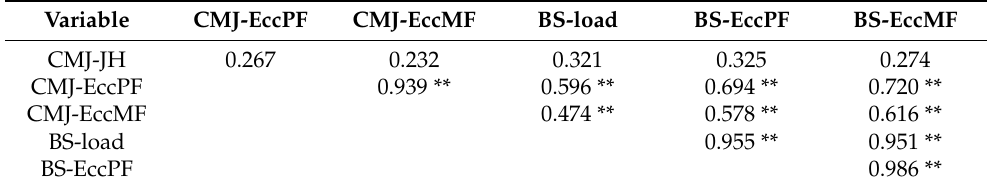
Table 2. Correlations between the CMJ and 1RM-BS measurements for the EccPF and EccMF. Variable